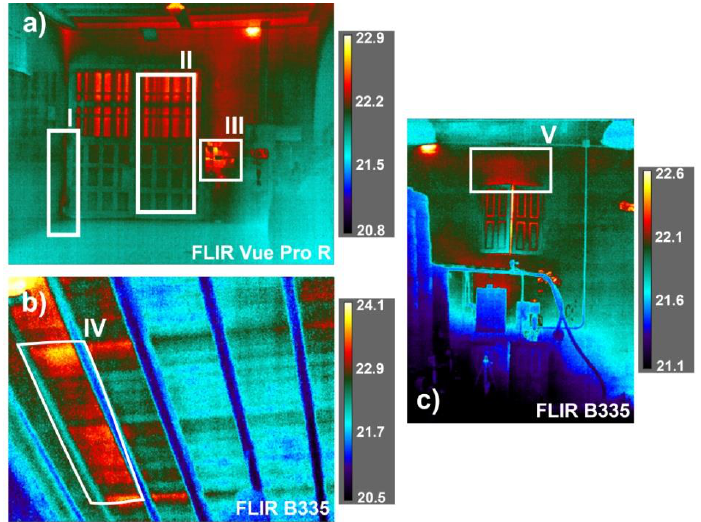
Figure 5. Thermal inspection of joineries inside the cellar: ( a ) Main door, ( b ) wooden ceiling of the wine-ageing room, and ( c ) a wall with a window. Some examples of detected thermal anomalies are highlighted: Air leakages (I) beside the door and (V) above the window, which heat the surface of the surrounding walls, (II) differences in the thicknesses of the upper and lower door leaves, (III) thermal radiation reflected by the ceramic tiles, which introduces noise into the image, and (IV) an area between floor joists with missing insulation. The temperature scale is in ◦